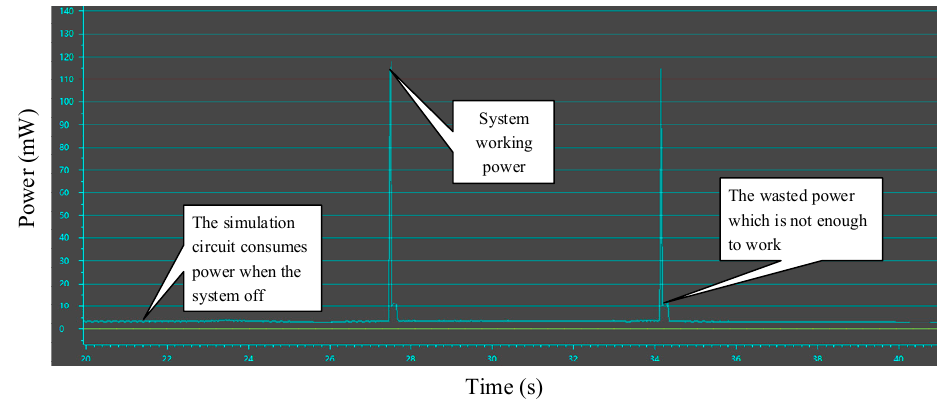
Figure 18. System operating power.